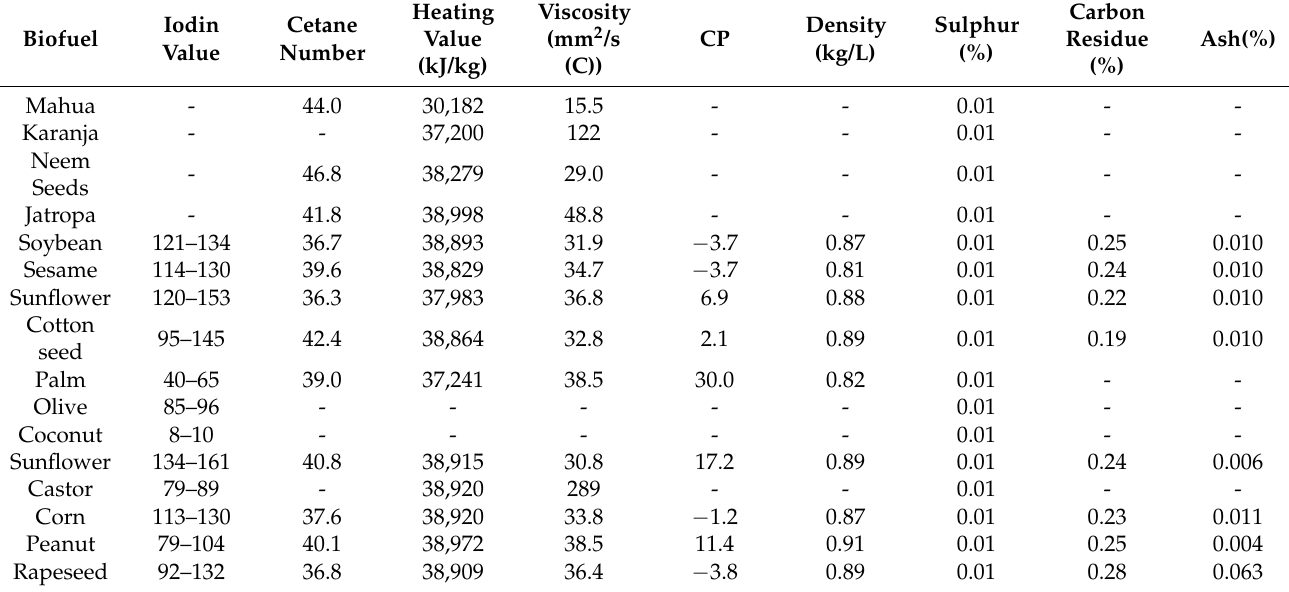
Table 3. Physicochemical properties of biofuels